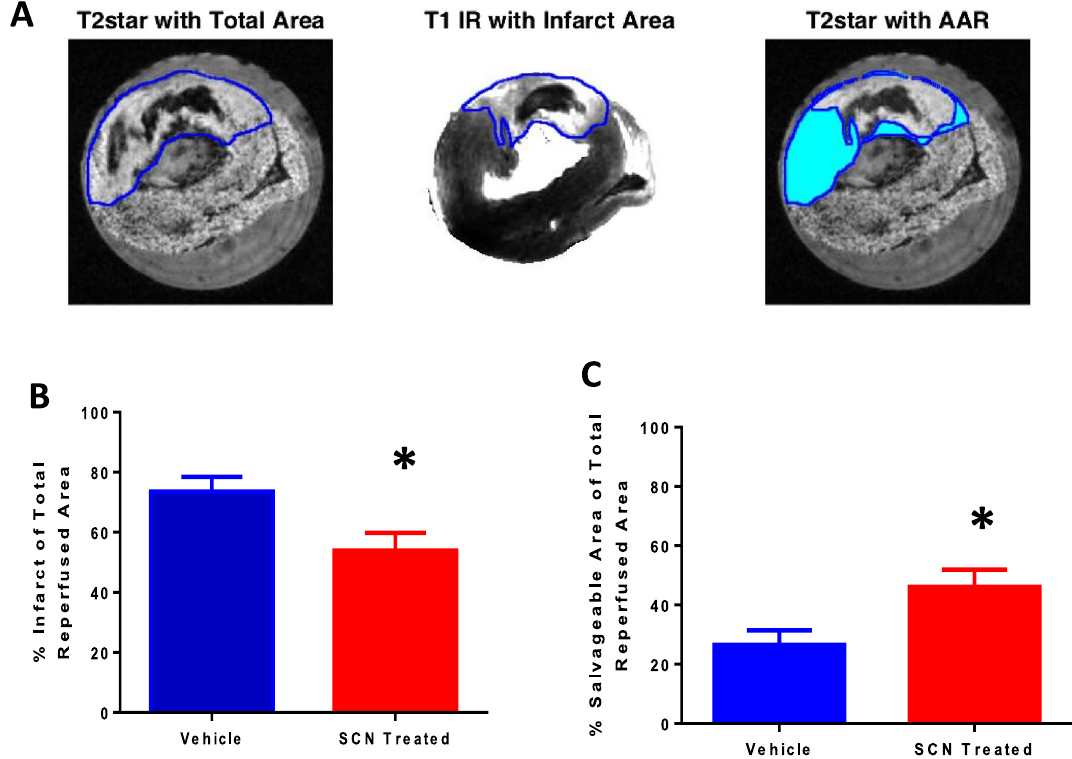
Figure 3. (A) Representative images of: (left) the total reperfusion area as determined by T2star MRI image analysis; (middle) infarct area determined by the T1 MRI image analysis; and (right) overlay of the T2star and T1 maps highlighting the salvageable area (AAR) in blue, at 24 h post IR surgery. (B ) Area of the infarct as a percentage of total reperfusion area for the vehicle IR and SCN – treated IR groups. (C) Salvageable area as a percentage of total reperfusion area for the vehicle IR and SCN – treated IR groups. * indicates a statistically- significant difference at the p < 0.05 level between the vehicle and SCN – treated rats subjected to IR injury, using a one-tailed Student’s